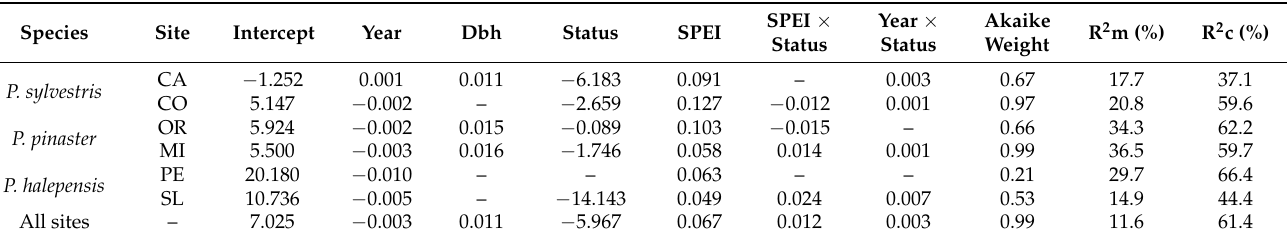
Table 4. Results of the linear mixed-effects models fitted to basal area increment data. The values show the estimated effects of each factor and its interactions. Tree status corresponds to living and dead trees. The last line corresponds to the global model fitted to all sites. See sites’ codes in Table 1.